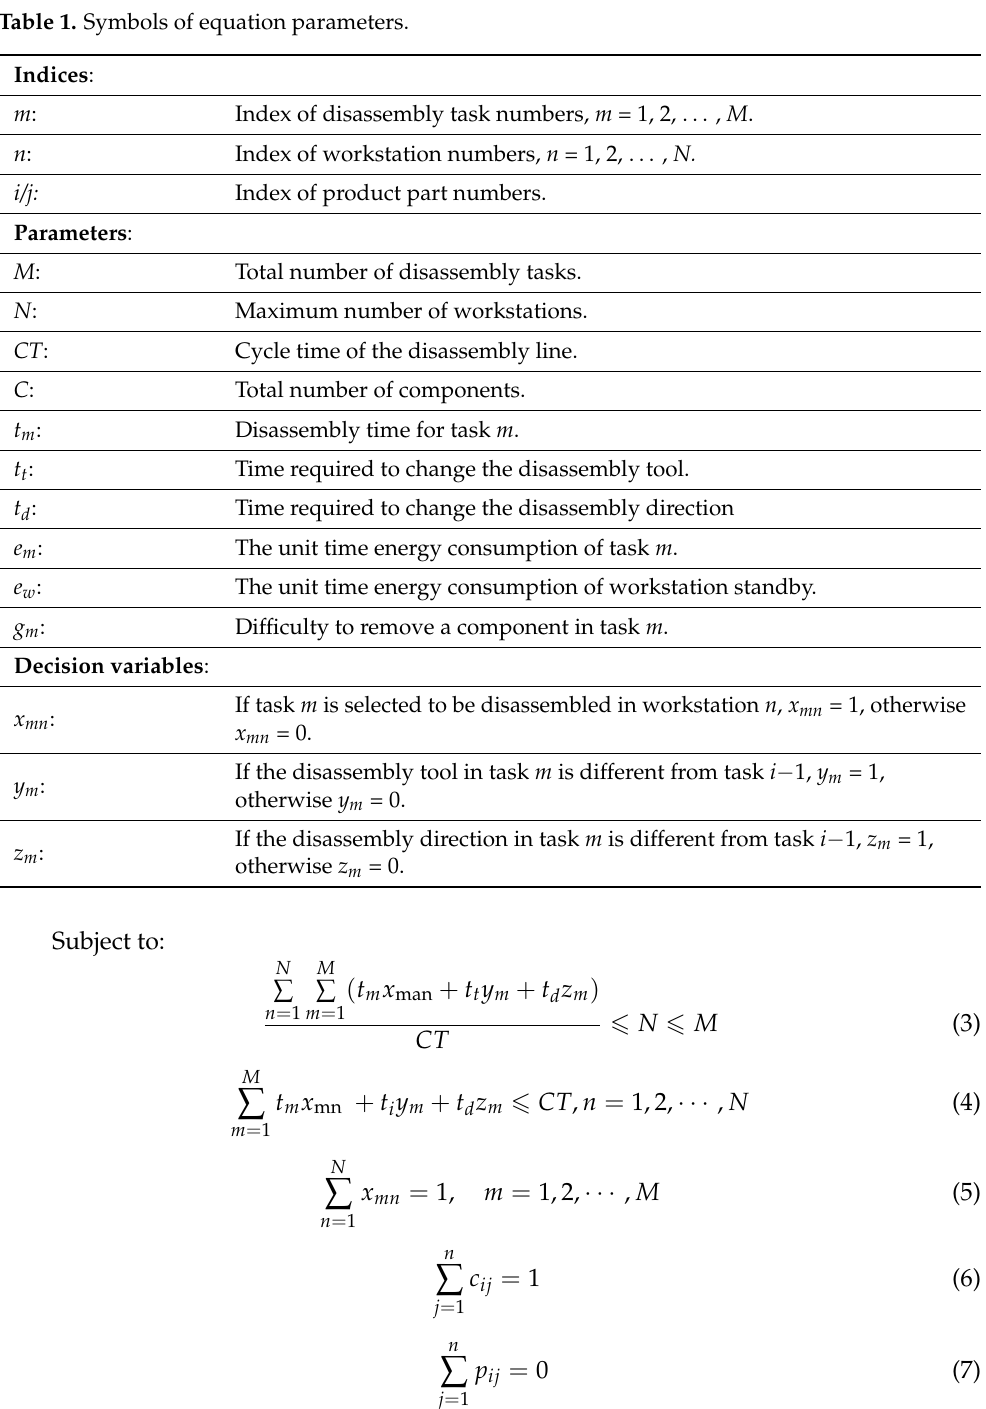
Table 1. Symbols of equation